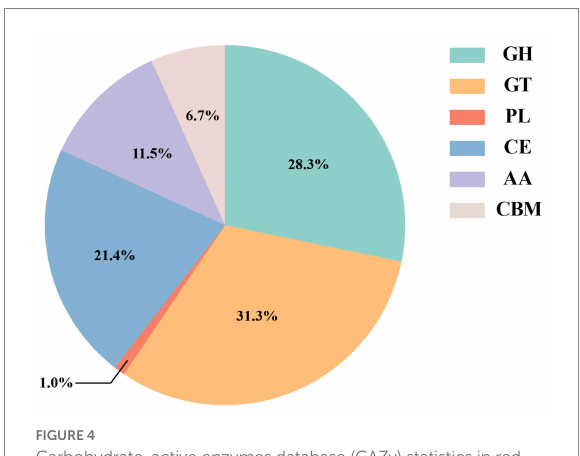
FIGURE 4 Carbohydrate-active enzymes database (CAZy) statistics in red vinasse acid.